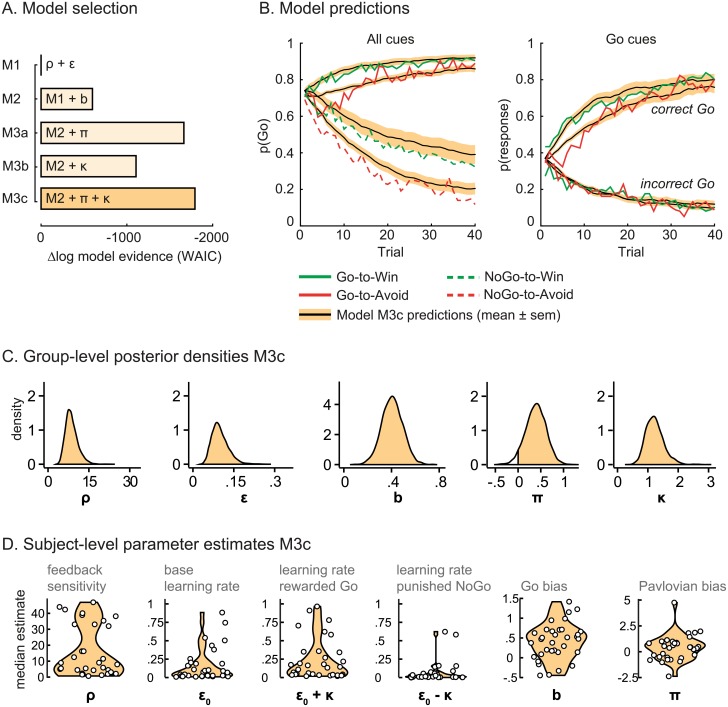
Computational modeling of Pavlovian response bias and instrumental learning bias.(a) Model evidence, relative to the simplest model, M1, favors M3c (marked by darkest color). The simplest model, M1, contains a feedback sensitivity (ρ) and learning rate (ε) parameter. Stepwise addition of the Go bias (b), Pavlovian bias (π), and instrumental learning bias (κ) parameter improves model fit. (b) Absolute post hoc model fit. The model predictions of winning model M3c (black lines; shaded areas indicate standard error of the mean) capture the key features of the data (colored lines); responses are learned (more Go responding for Go cues versus NoGo cues) and a motivational bias is present (more Go responding for “win” versus “avoid” cues). (c) Posterior densities of the winning model M3c. The group-level estimates are positive for the Go bias (100% samples > 0), the Pavlovian bias (95.5% samples > 0), and the instrumental learning bias (100% samples > 0). (d) Subject-level parameter estimates of the winning model M3c. The feedback sensitivity and learning rate were strongly anticorrelated over subjects (R = −0.77, p < 0.001) such that the impact of high feedback sensitivity was limited by a low learning rate. Subjects have increased learning rates for rewarded Go responses (ε0 + κ) and decreased learning rates for punished NoGo responses (ε0 − κ), which we refer to as the instrumental learning bias. Note that κ is added to ε0 prior to {0 1}-constraining; see S2 Text. Underlying data can be found at http://hdl.handle.net/11633/di.dccn.DSC_3017033.03_624. WAIC, Watanabe–Akaike Information Criterion.